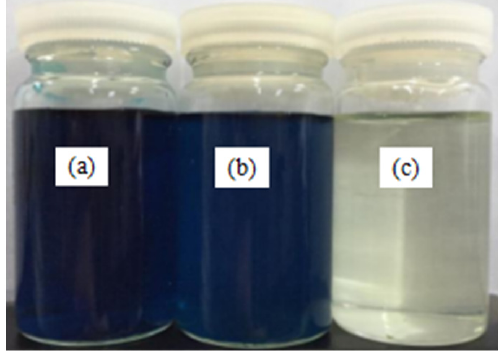
10 of 22 Figure 9. ( a ) Effect of pH on adsorption performance of MDG and ( b ) zeta potential analysis of DG and MDG.